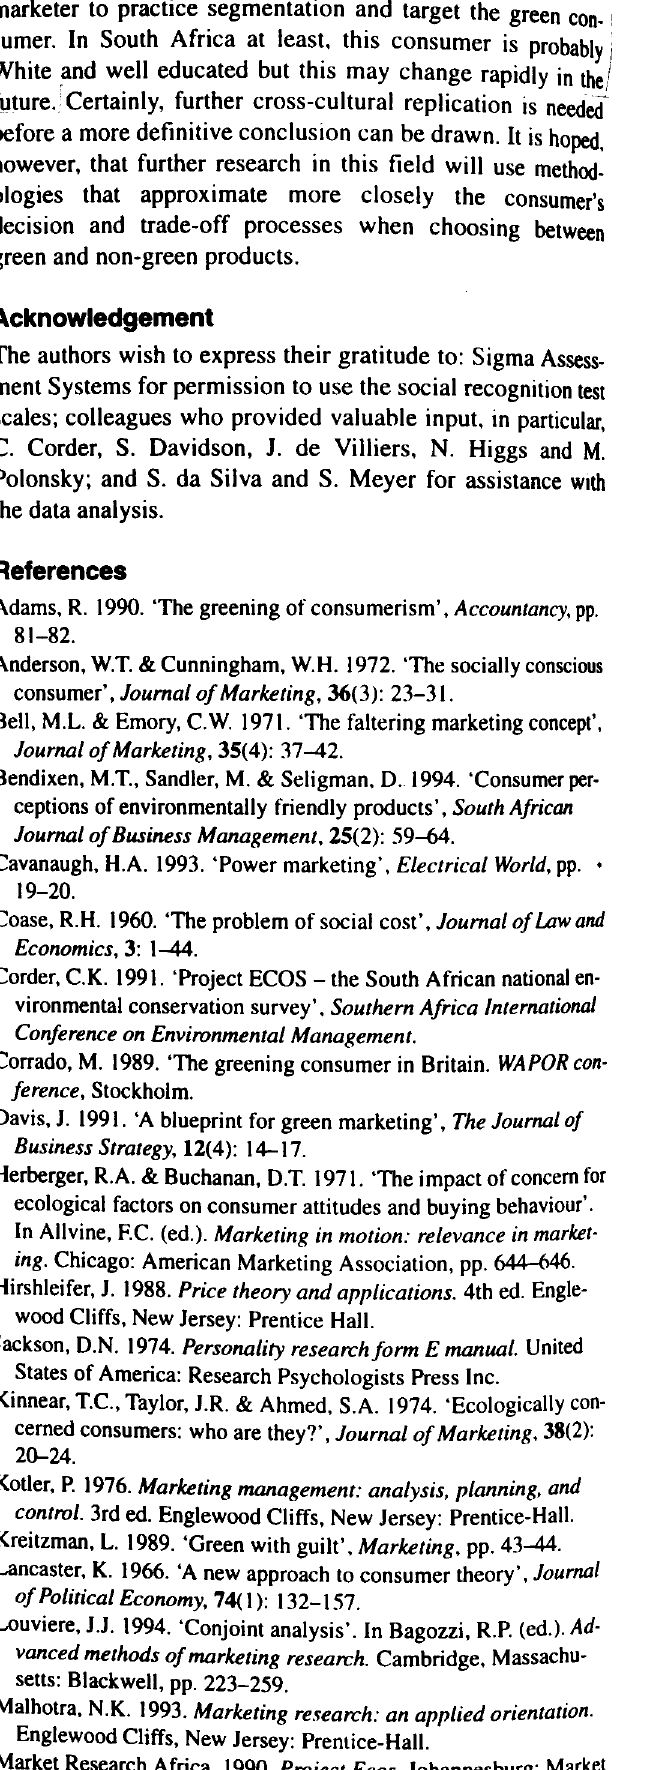
Table 6 Results of